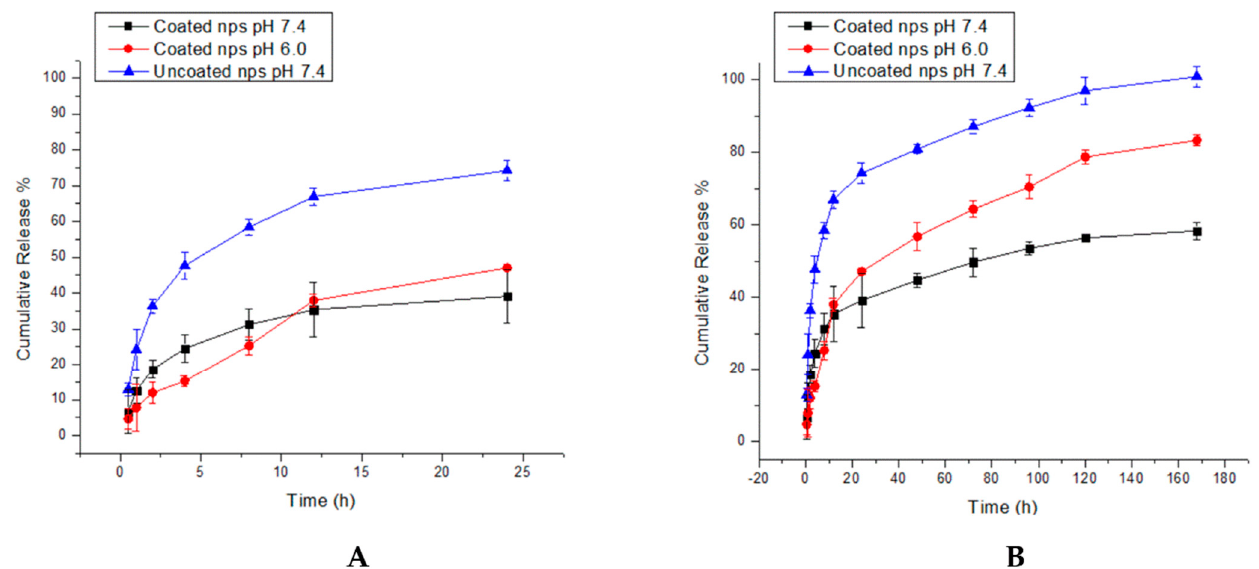
Figure 7. Release curves of quercetin from coated and uncoated nanoparticles ( A ) 24 h and ( B ) 168 h.